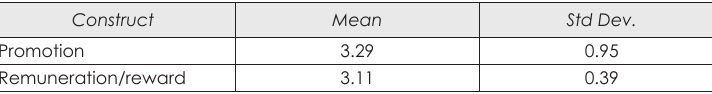
Table 17: Aggregated means of employee perception constructs Construct Std